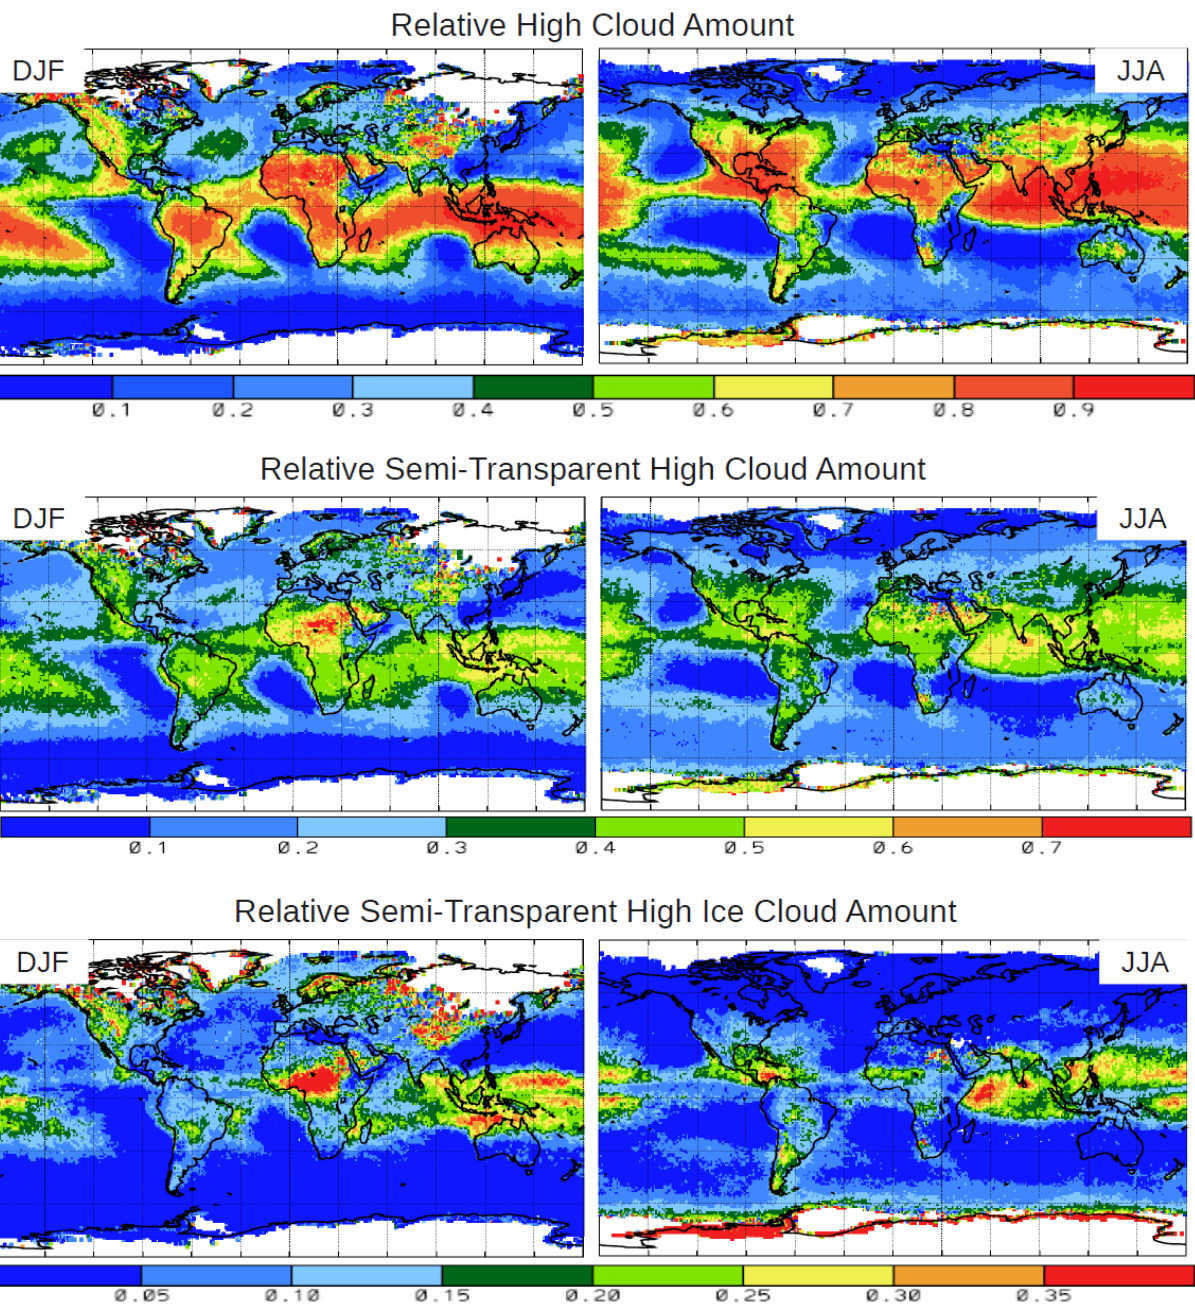
Fig. 8. Geographical maps of high cloud amount (top), semi-transparent high cloud amount (middle) and of semi-transparent high ice cloud amount (bottom), relative to total cloud amount, for boreal winter (right) and boreal summer (left). Statistics is averaged over the period 2003-2009.